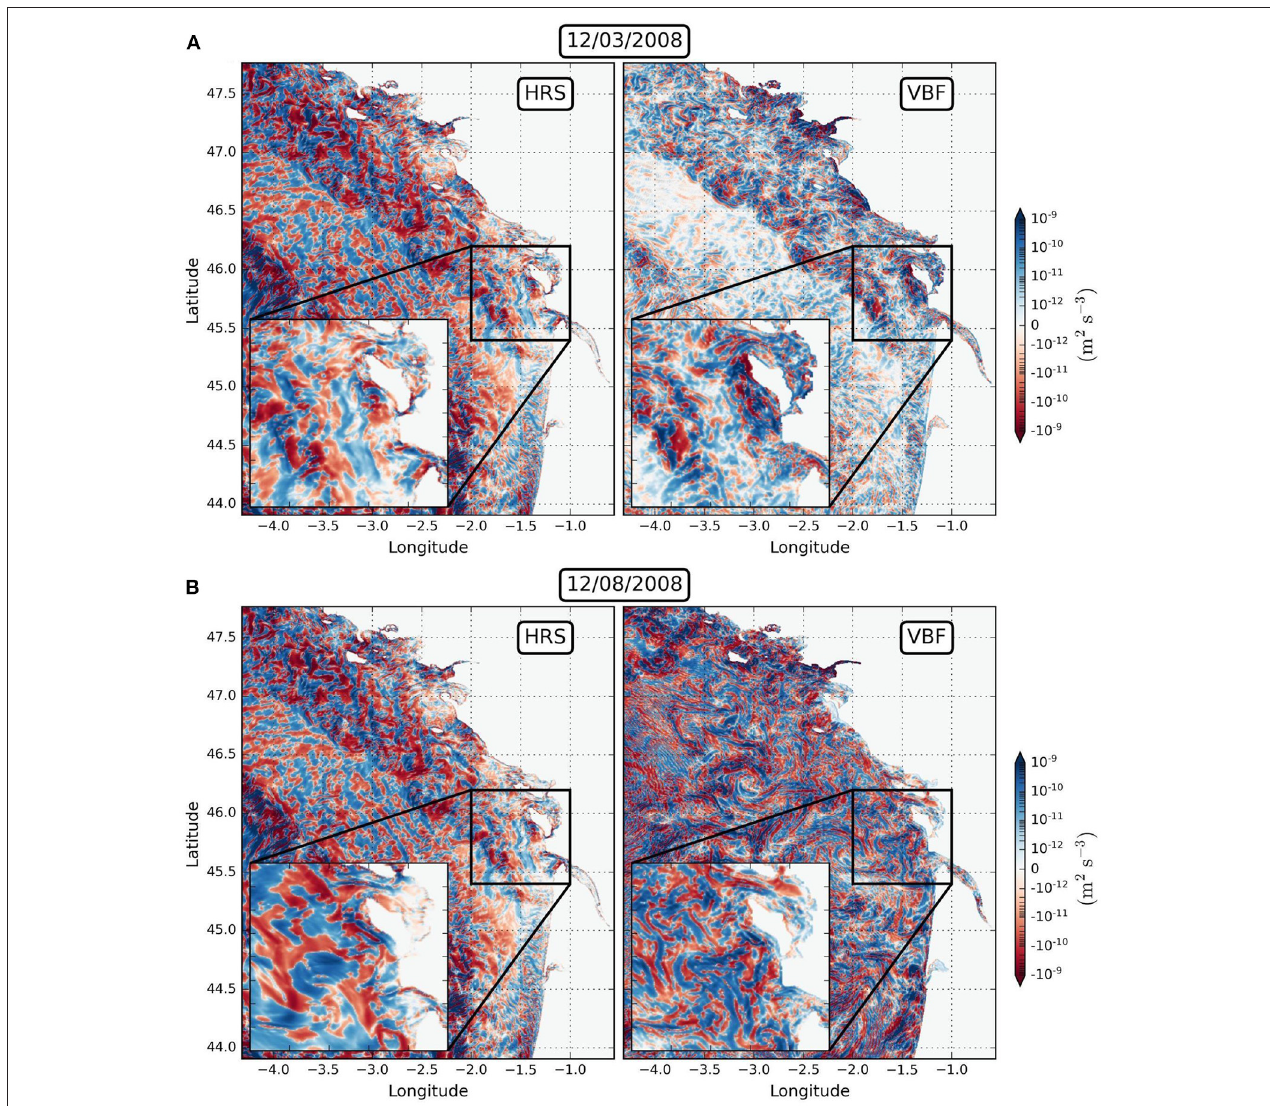
FIGURE 11 | HRS and VBF energy conversion terms at 5 m in March (A) and in August (B) 2008. The left corner panel indicates a zoom on the region delimited by the black solid box centered on the Gironde river plume.